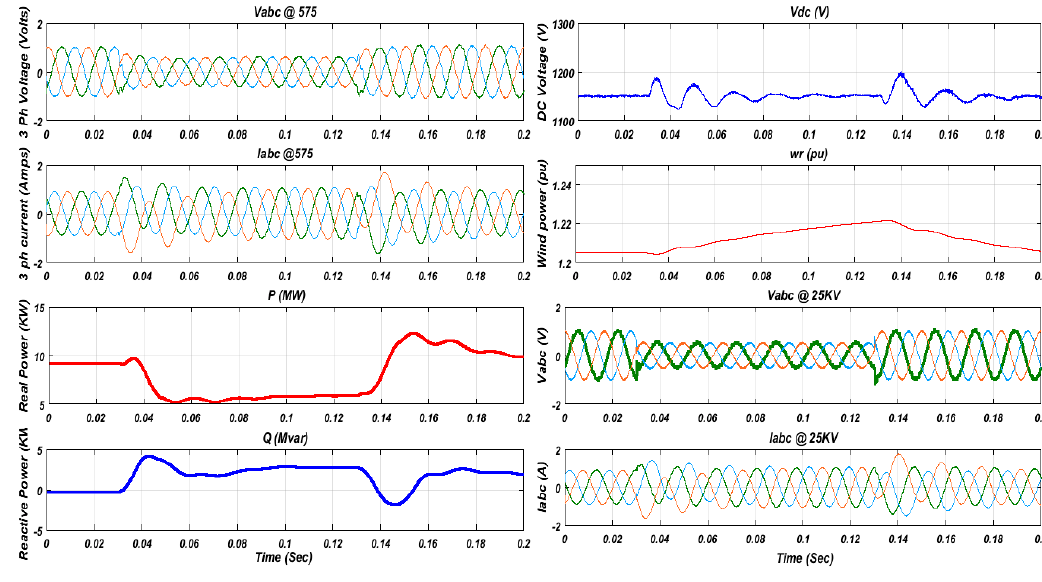
Figure 7. Wind farm results for 575 V and 25 KV.